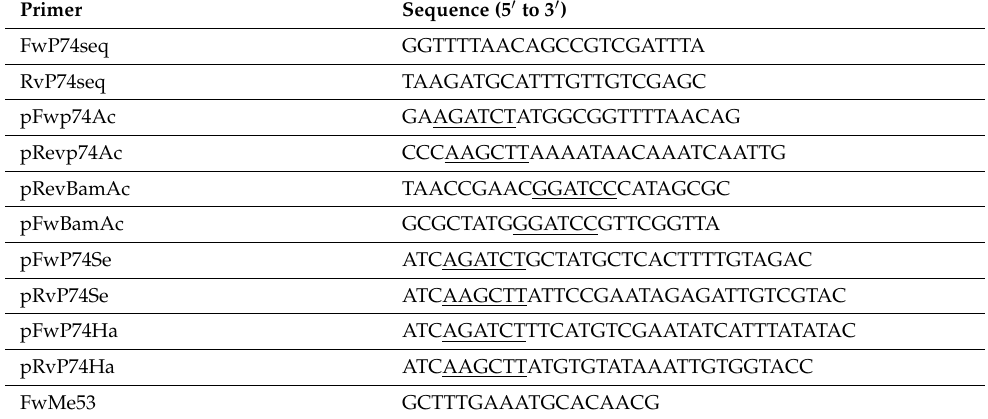
Table 1. List of PCR